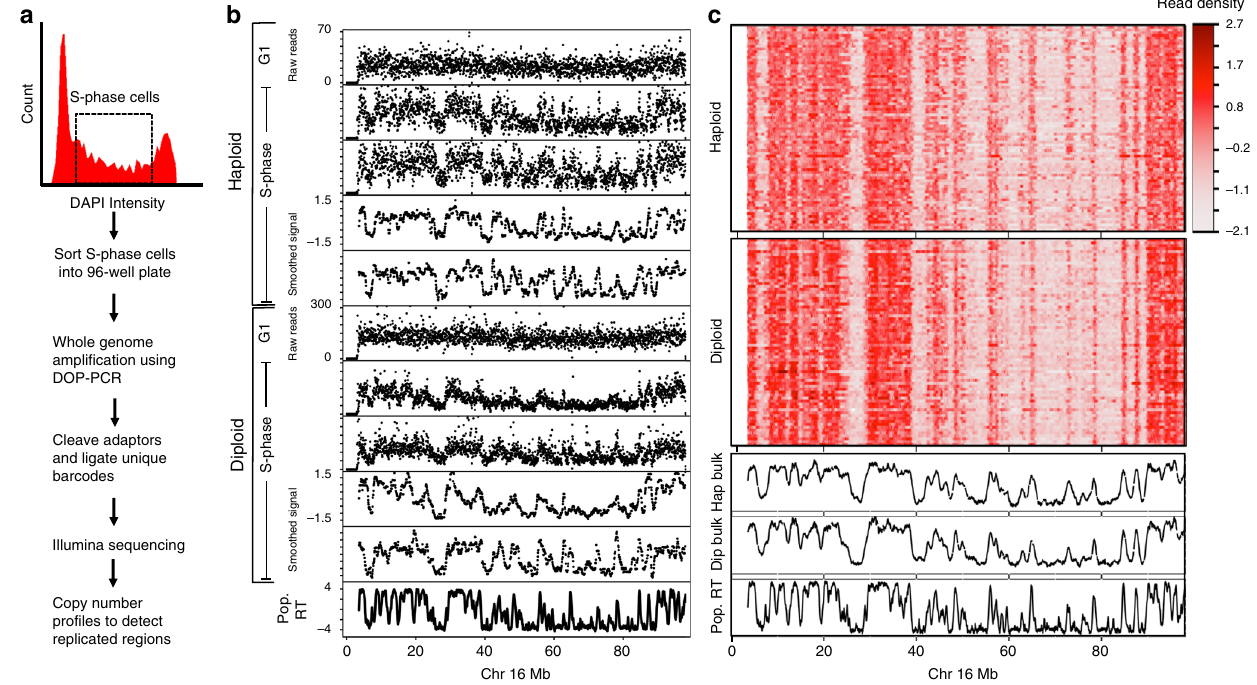
Fig. 1 Single-cell replication using copy number variation. a Method for generating single-cell CNV pro fi les. b Representative single-cell CNV pro fi les of G1 and S-phase cells in both haploid and diploid hybrid cells. CNV pro fi les are shown as raw read count in 50 kb bins and after smoothing and corrections. c Heatmap of all single-cell CNV pro fi les after smoothing and corrections. The bottom three panels show aggregate of haploid single cells, aggregate of diploid single cells, and replication timing measured using population-based Repli-seq in the diploid hybrid